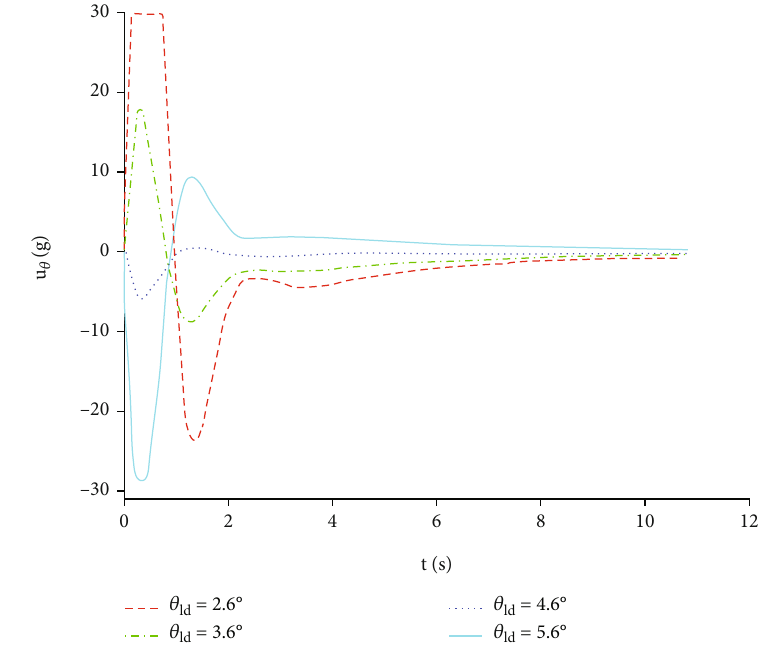
Figure 3: Missile acceleration